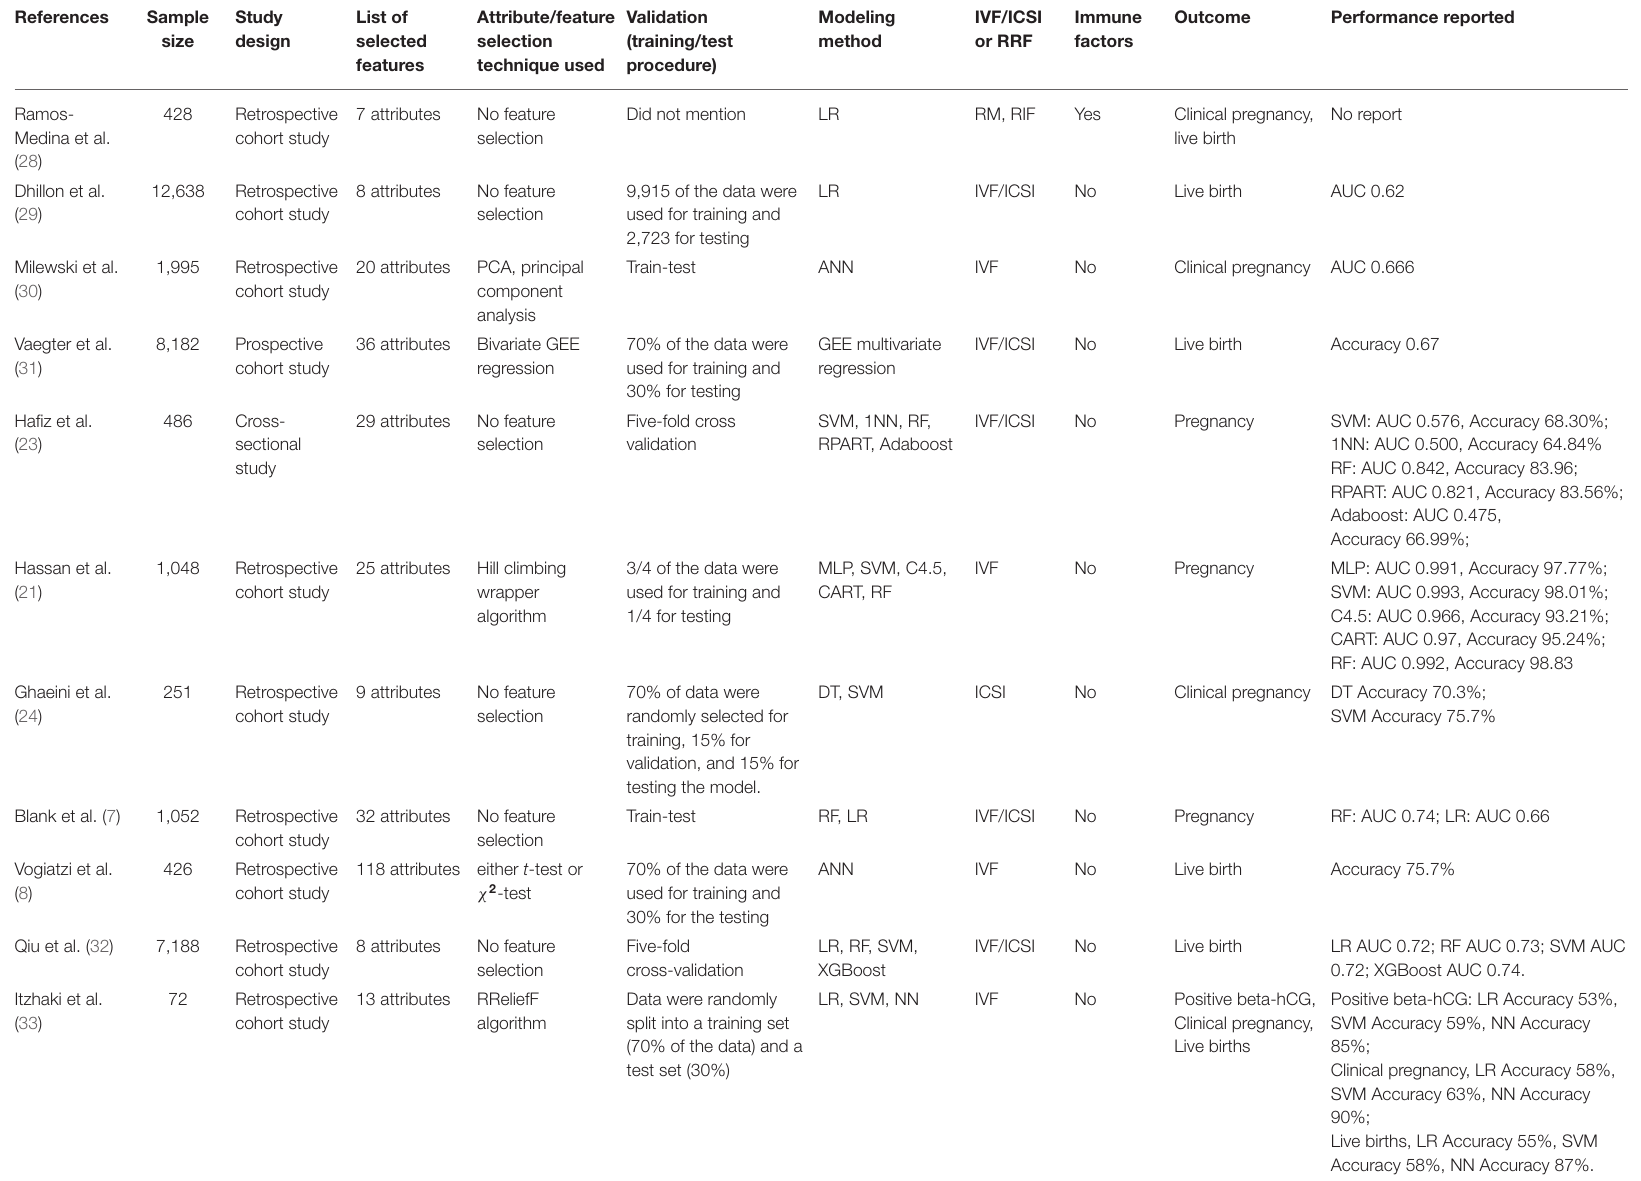
TABLE 1 | Recent representative literature related to predictive models for patients with infertility or